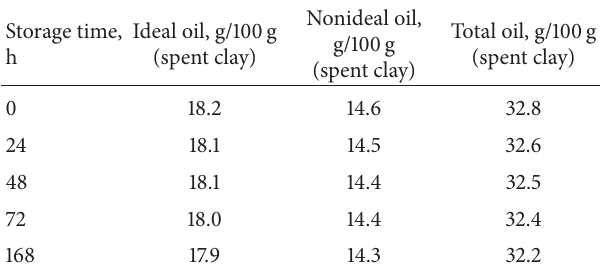
Table 5: The influence of storage time on the oil